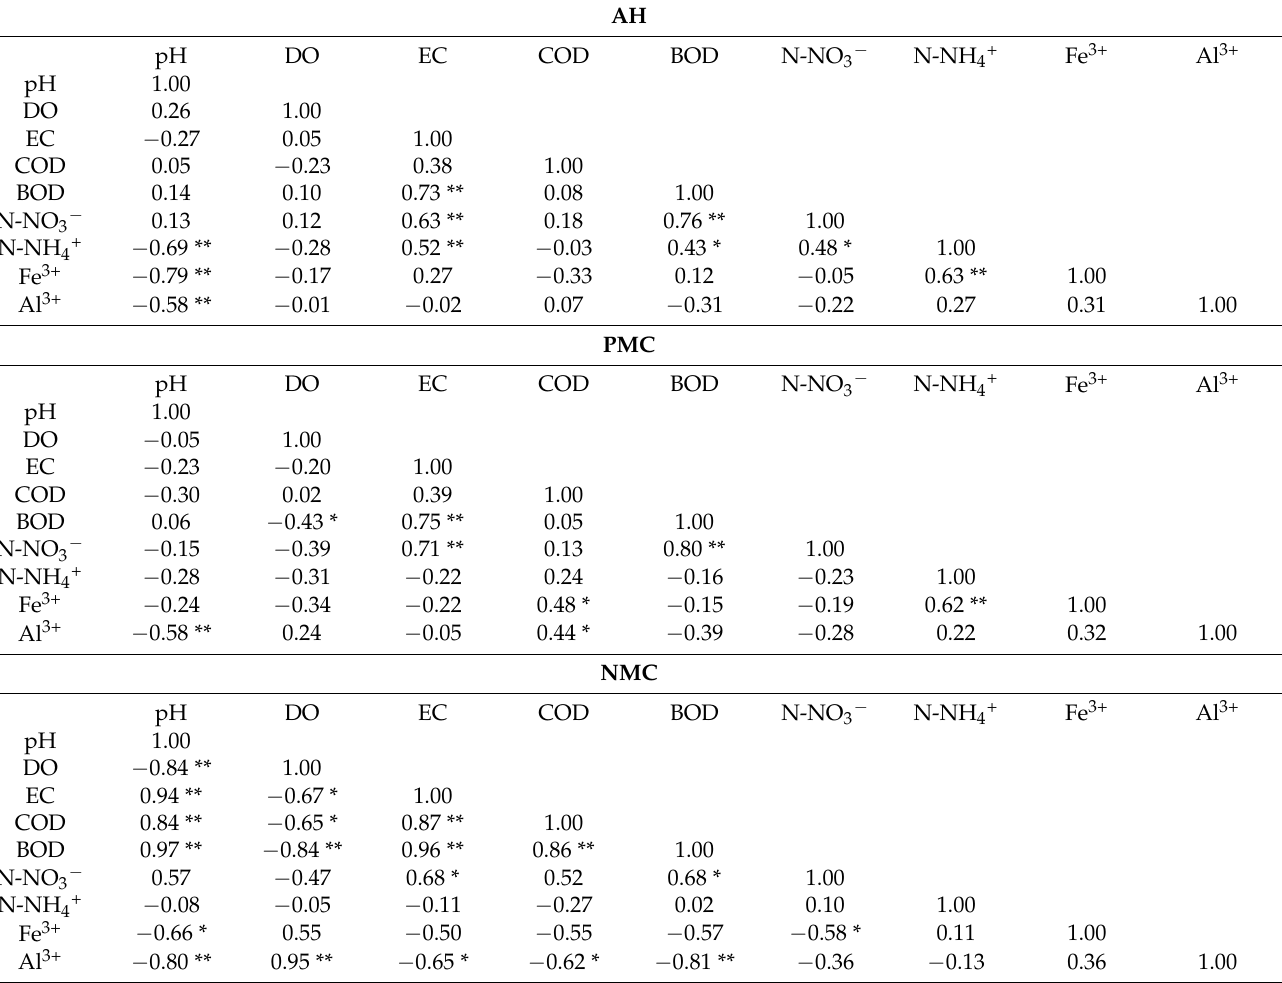
Table 3. Correlation coefficient between the water quality parameters and various land use